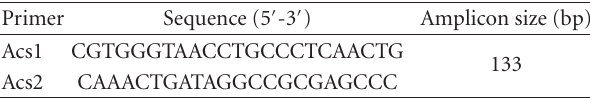
Table 1: Primer design for A. suis PCR